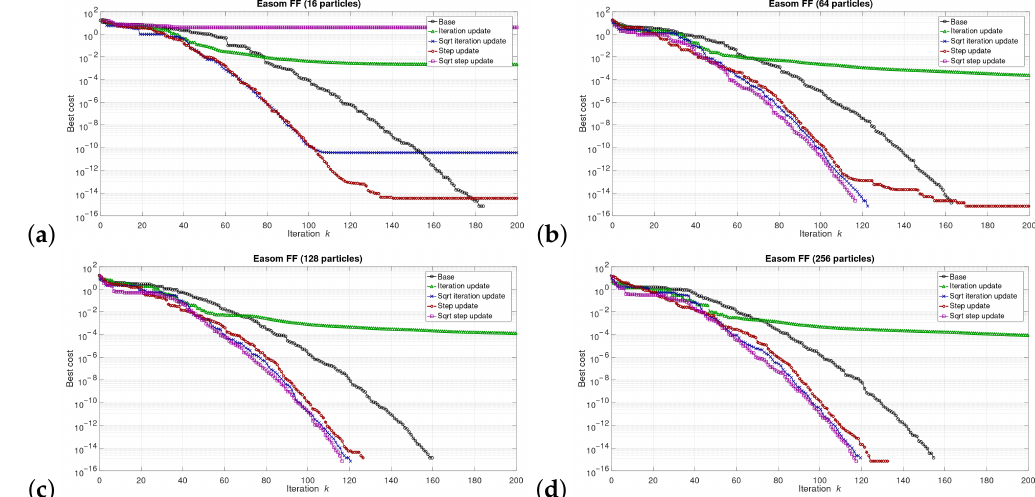
Figure 4. Selected results for Easom FF for ( a ) 16, ( b ) 64, ( c ) 128, and ( d ) 256 particles.